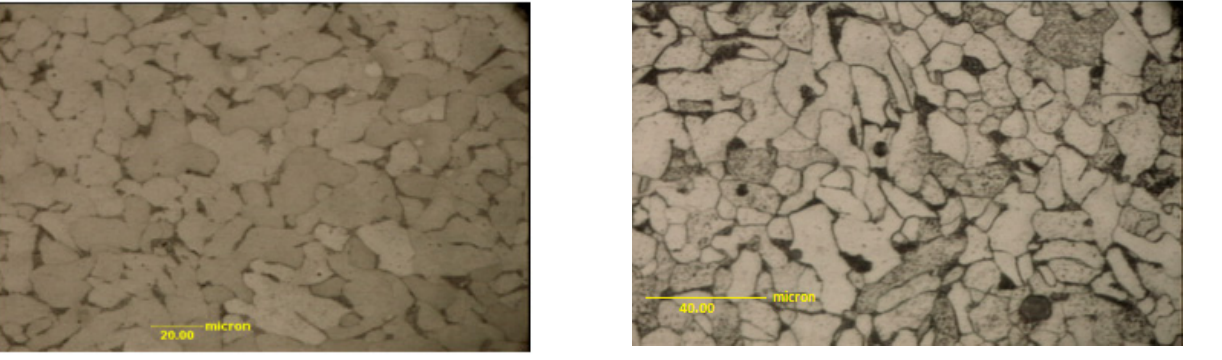
Figure 8: Structure of undeformed specimen. Figure 9: Void nucleation at grain